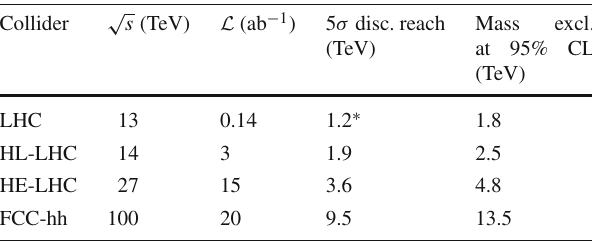
Table 7 Summary of the expected 5 σ discovery sensitivity and expected 95% CL exclusion sensitivity to S 3 for future hadron col- liders, from LQ pair production. ∗ The predicted discovery reach of the 13 TeV LHC at 140 fb − 1 of m LQ = 1 . 2 TeV is currently on the edge of exclusion at 95% CL (see Fig.